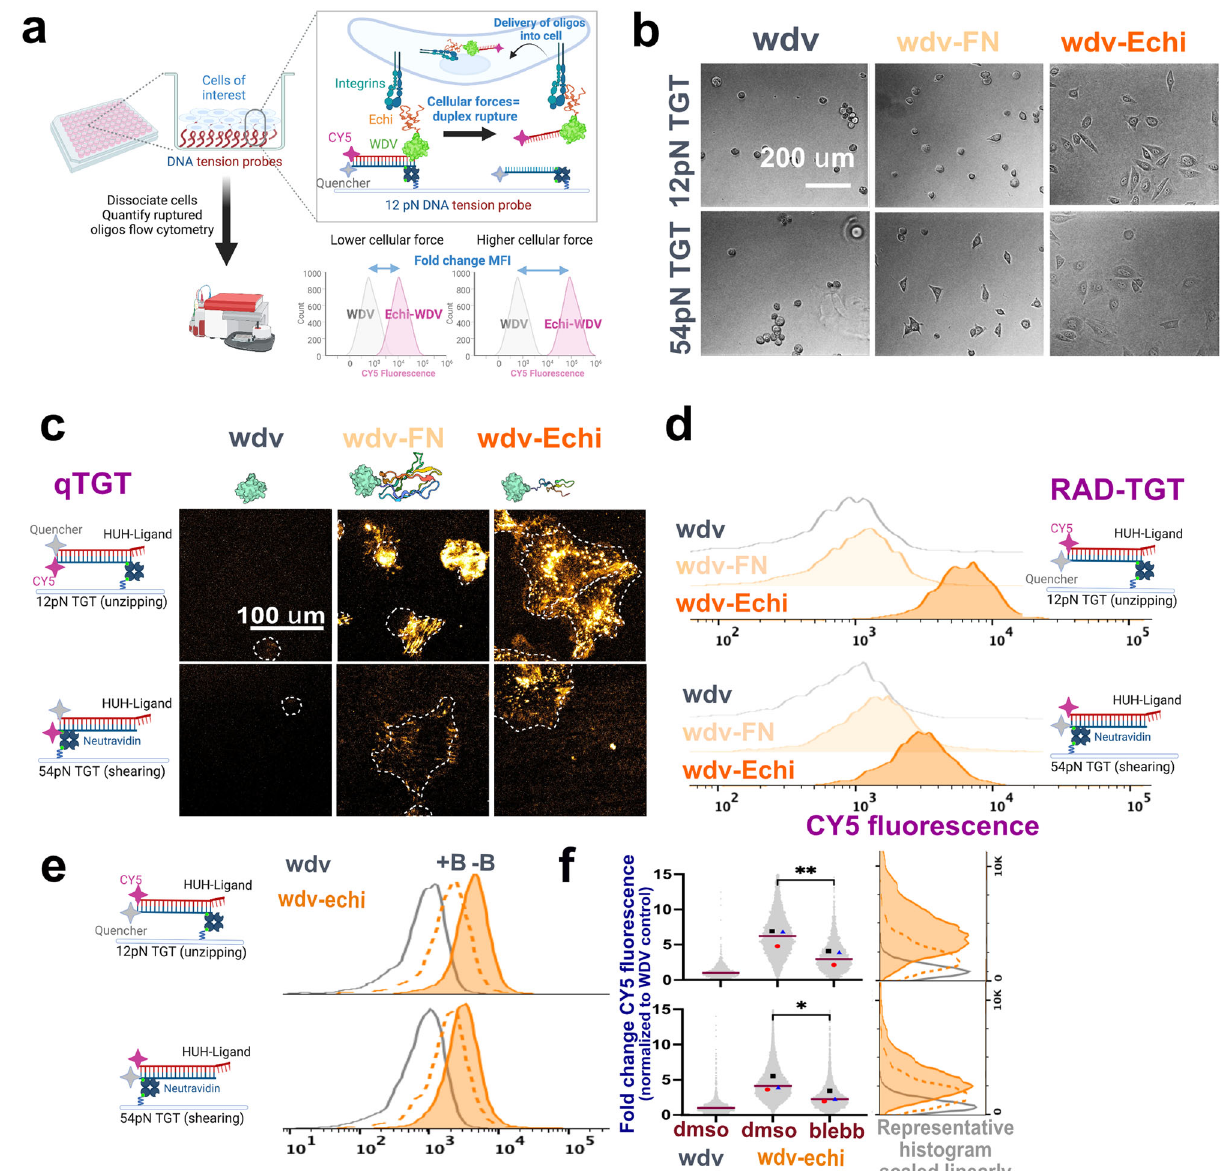
f SuperPlots of CY5 fl uorescence of each cell from three biological replicates nor- malized to WDV median fl uorescence with symbols for medians of biological replicates. Representativehistograms turned 90°and scaled linearly forreference. Gray histograms are WDV only, dotted lines are with para-amino-Blebbistatin, and solid orange is with DMSO treatment as control. ** p =0.001387, * p =0.015441. Statistics were performed using one-way ANOVA of the medians of biological replicates. Source data are provided as a Source Data fi le. All cartoons and sche- matics were created with